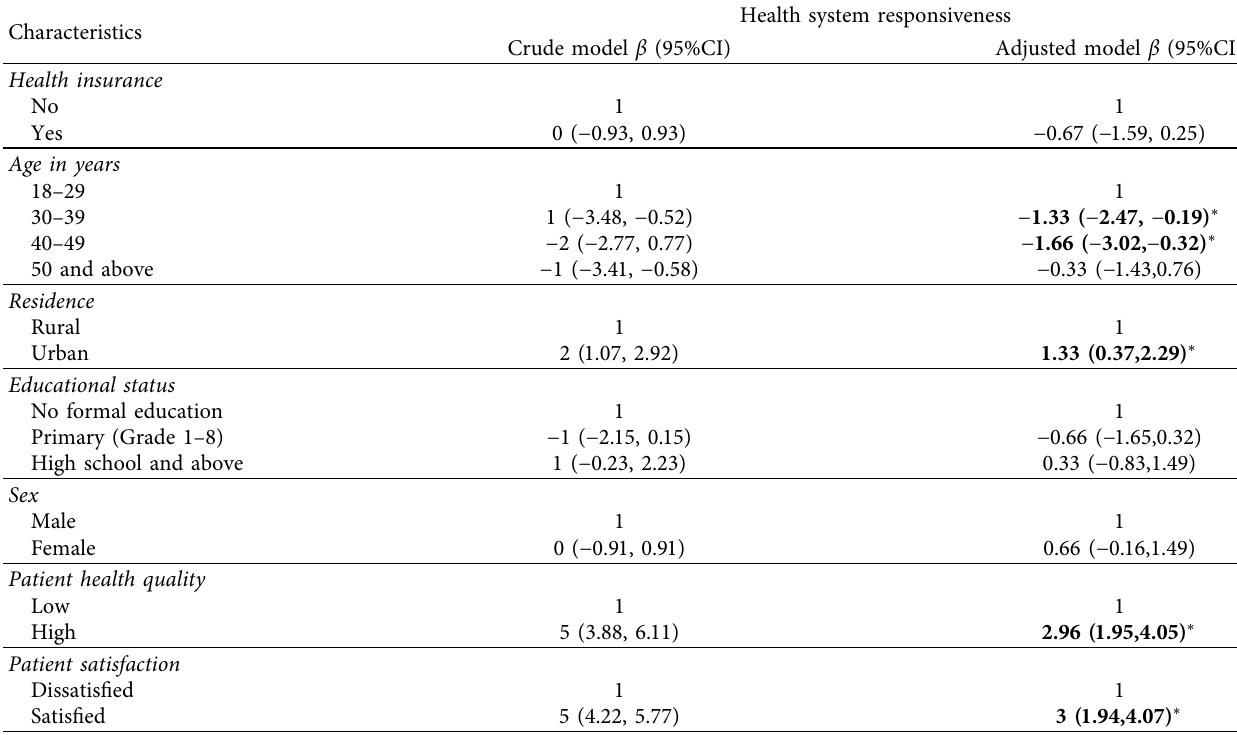
Table 4: Results of crude and adjusted median quantile models for responsiveness to health care services in primary healthcare facilities, in Ethiopia ( n �